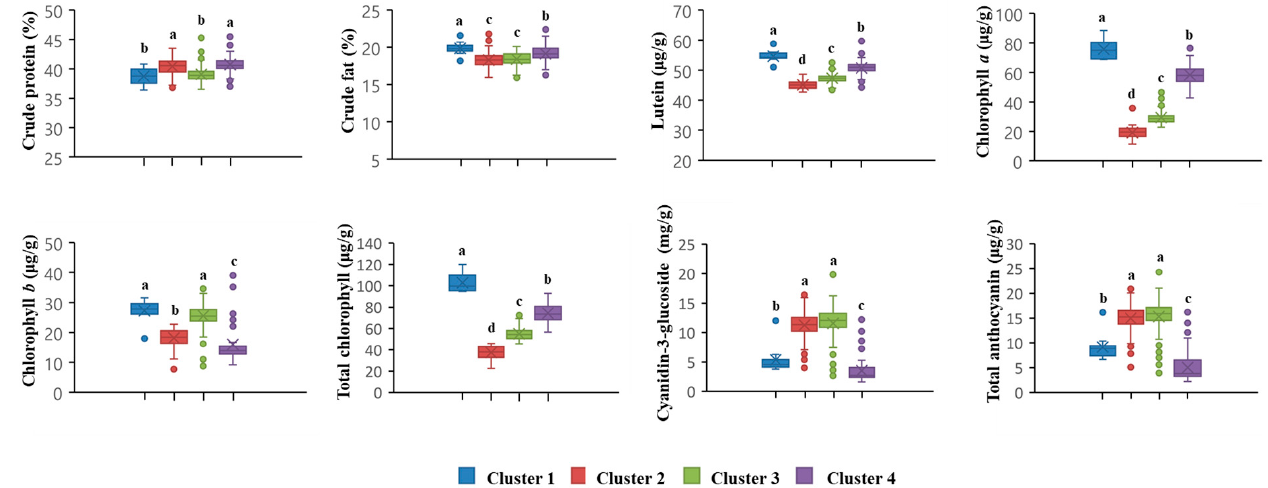
Figure 4. Box plots of crude protein, crude fat, lutein, chlorophylls, and anthocyanins in 4 clusters of 468 black soybean germplasms with green cotyledons, including check cultivars ‘Cheongja’ and ‘Cheongja 3 ′ . The letters above the bars are statistically different based on the least square difference.